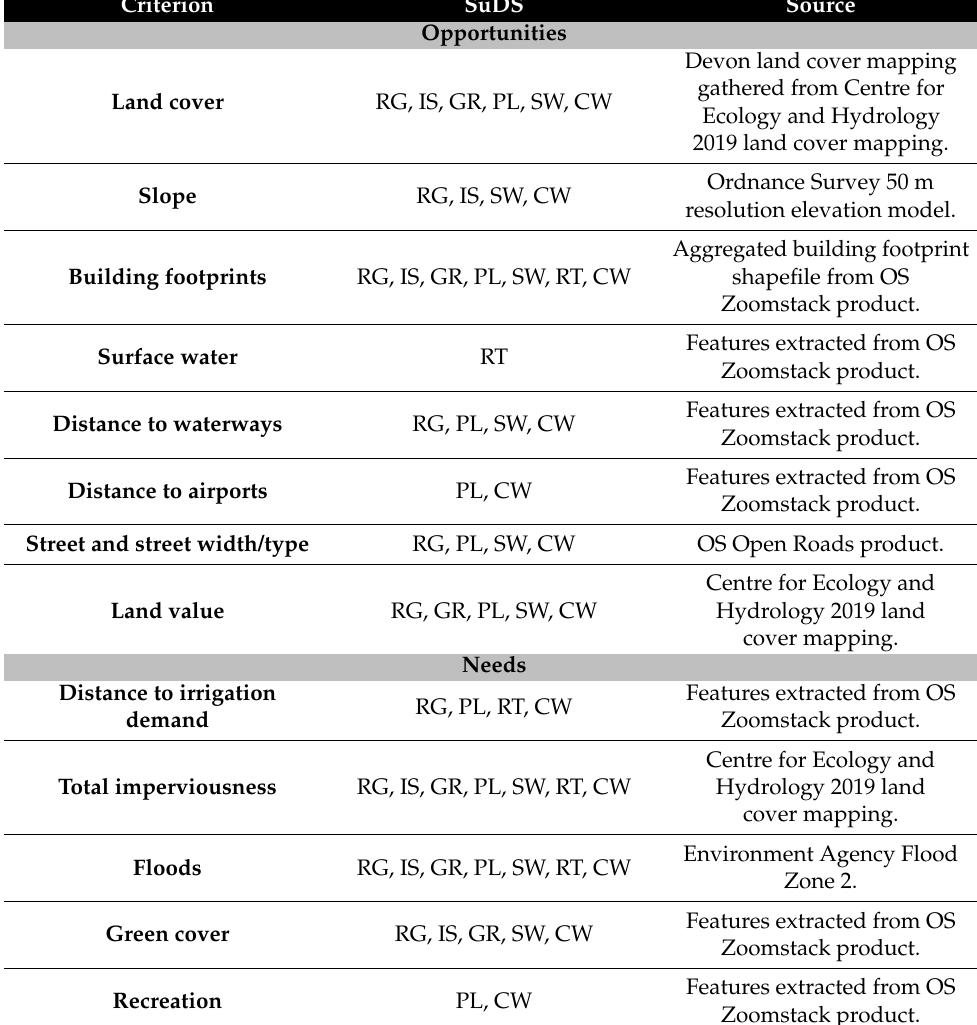
Table 1. Data types applied in this study, specified per SuDS type. RG: rain gardens and bioretention systems, IS: infiltration system, GR: green roofs, PL: ponds and lakes, SW: swales, RT: rain tanks, CW: constructed wetlands. Criterion SuDS Source Opportunities Devon land cover mapping gathered from Centre for Land cover RG, IS, GR, PL, SW, CW Ecology and Hydrology 2019 land cover mapping. Ordnance Survey 50 m RG, IS, SW, CW resolution elevation